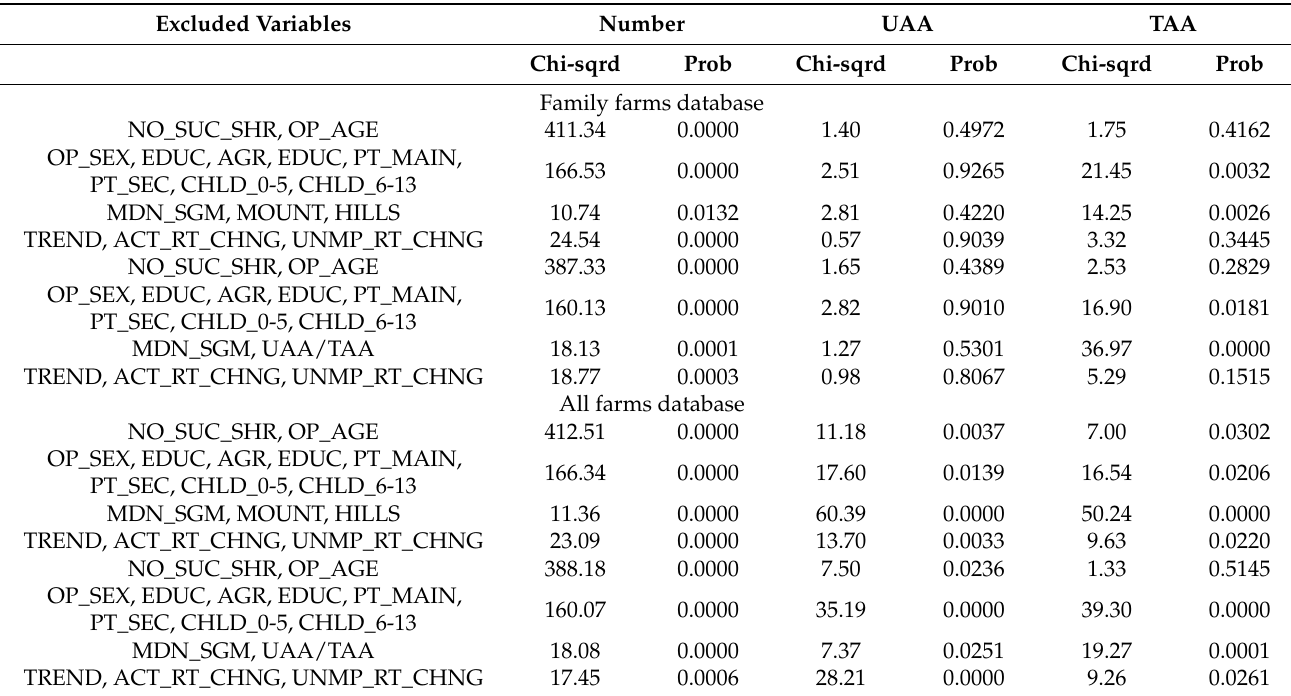
Table A8. Likelihood ratio tests on the exclusion of groups of